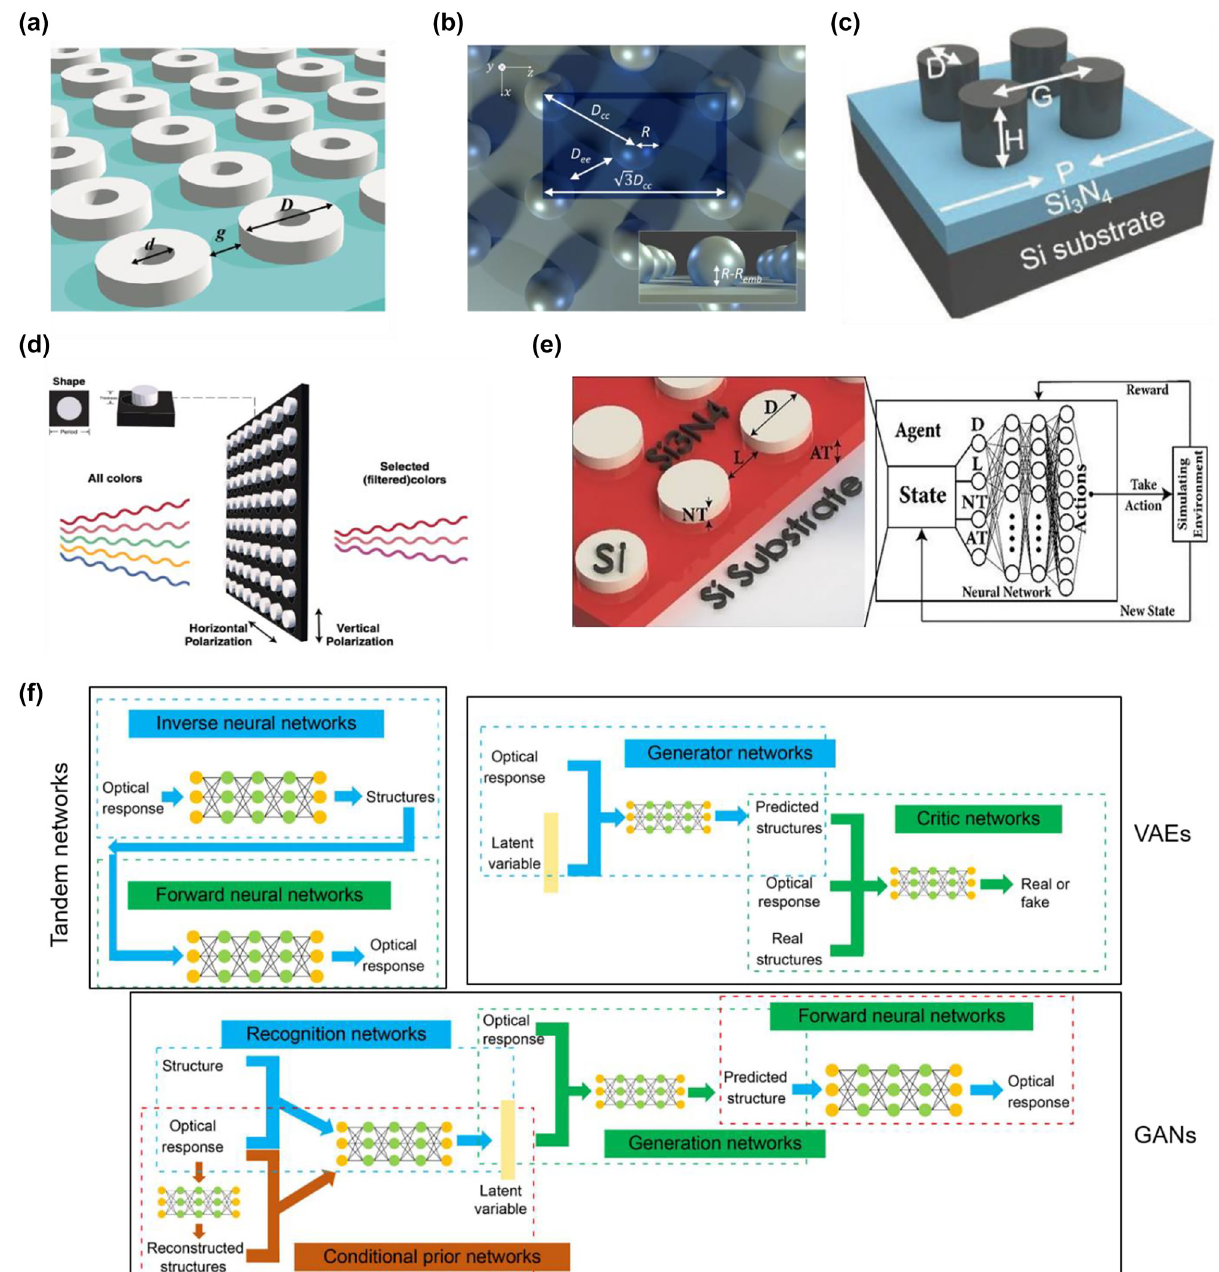
Figure 17: Machine learning-based approaches for structural color design. (a) Dielectric ring structure for structural color generation. The inner diameter d , outer diameter D , and the inter-ring gap g are predicted for a given color target. Reproduced with permission [186]. Copyright 2019, Royal Society of Chemistry. (b) Laser-induced nanoparticles for structural color generation. The optimal laser machining parameters are optimized with a deep neural network model. Reproduced with permission [175]. Copyright 2019, Nature Publishing Group. (c) Silicon nanorod structure designed by tandem networks. The design parameters are the diameter D , height H , gap G , and period P . Modified with permission [174]. Copyright 2019, Wiley-VCH. (d) Free-form silicon metasurface structure designed by GANs. Modified with permission [191]. Copyright 2021, Wiley. (e) Silicon nanorod structure designed by the reinforcement learning algorithm. Reproduced with permission [195]. Copyright 2019, Optica Publishing Group. (f) Neural network architectures for tandem networks (top left), Variational autoencoders (VAEs, top right), and generative adversarial networks (GANs, bottom). Modified with permission [192]. Copyright 2022, China Science Publishing and Media (CSPM)